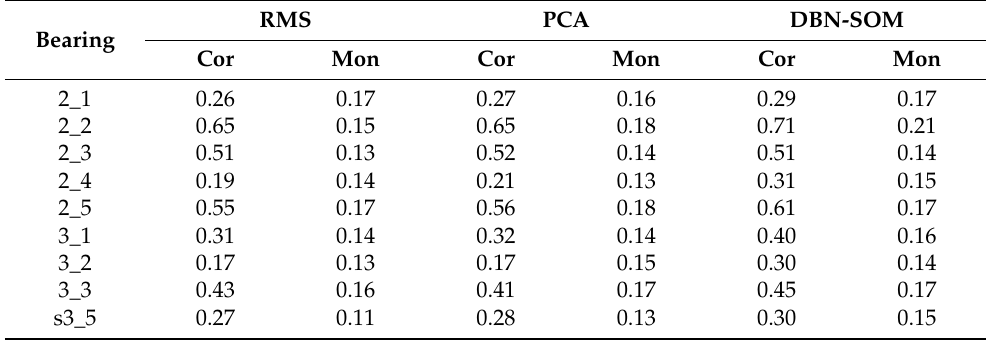
Table 1. The monotonicity and correlation results of HI curves for RMS, PCA, and DBN-SOM methods.